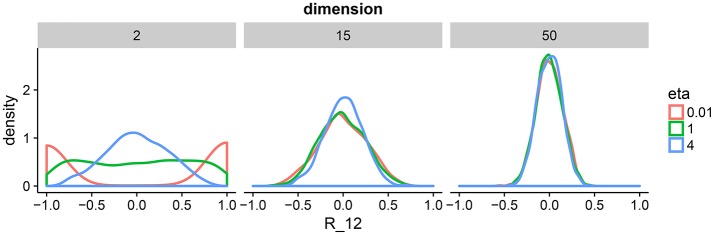
Density plots of 1,000 draws from the LKJ prior in 2, 15, and 50 dimensions. We plot one off-diagonal element in the correlation matrix for each matrix R drawn form the LKJ prior. We pick element (1, 2) denoted by R12. This is representative of the other elements in the matrix because the LKJ prior is symmetric. We evaluate different shape parameters η. In the low-dimensional setting, a small η assigns larger probability mass to correlations close to −1 and 1, whereas a large η assigns larger mass around 0. In the high-dimensional setting, probability mass is concentrated around 0 irrespectively of η. The special case of η = 1 represents the uniform distribution on correlation matrices.